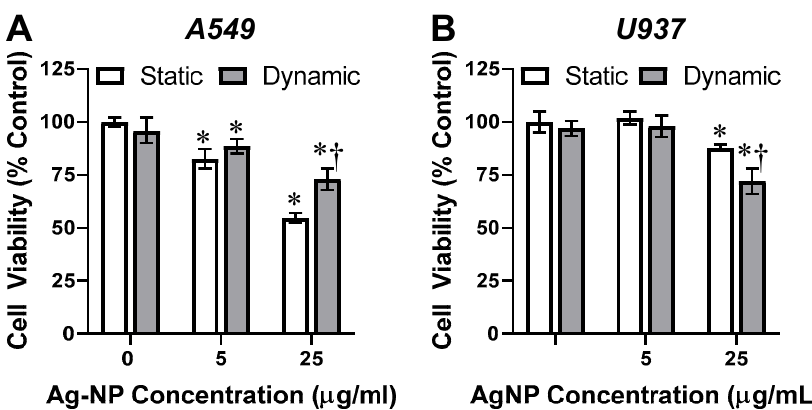
Figure 3. Cellular viability following AgNP exposure. Following 24 h AgNP exposure within either ( A ) A549 or ( B ) U937 models the cellular viability was assessed. These results indicated that within both systems viability was a function of AgNP dosage and flow condition. * and † indicate statistical significance compared to the untreated control and between static and dynamic conditions, respectively. n = 3, p < 0.05.